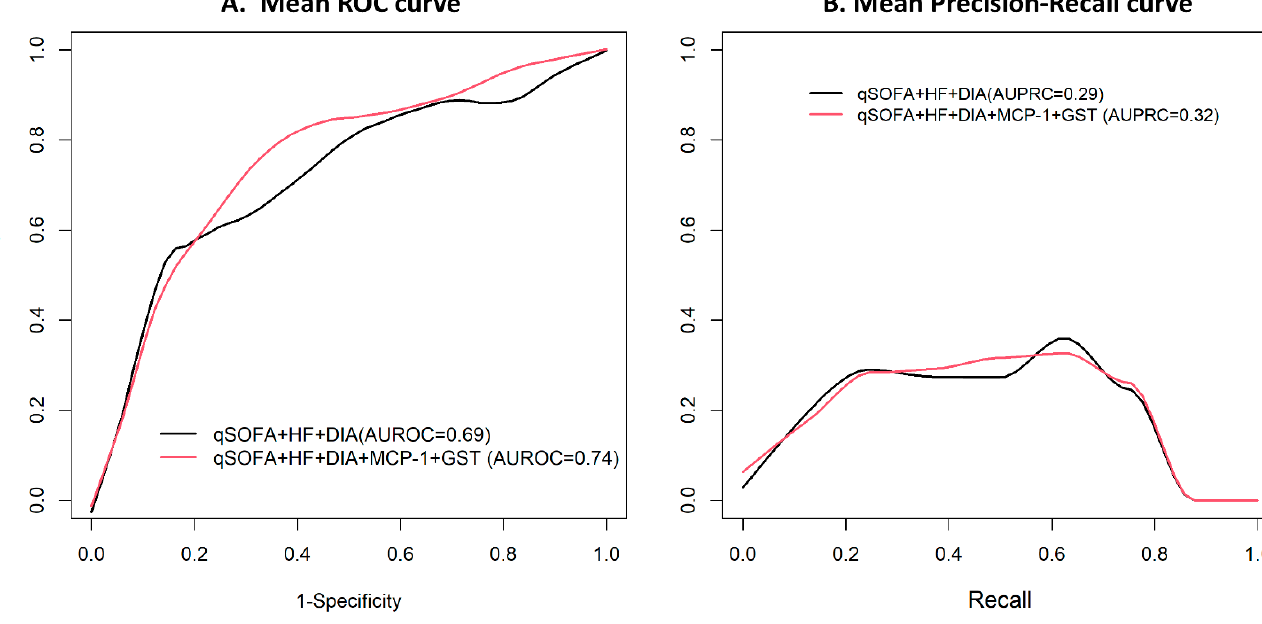
Figure 4. Comparison of prediction accuracy for clinical variable-based model versus cytokine and renal toxicity-based model for predicting in-hospital death in patients with COVID-19. qSOFA: qSOFA ≥ 1 vs. < 1; HF: heart failure; DIA: dialysis.